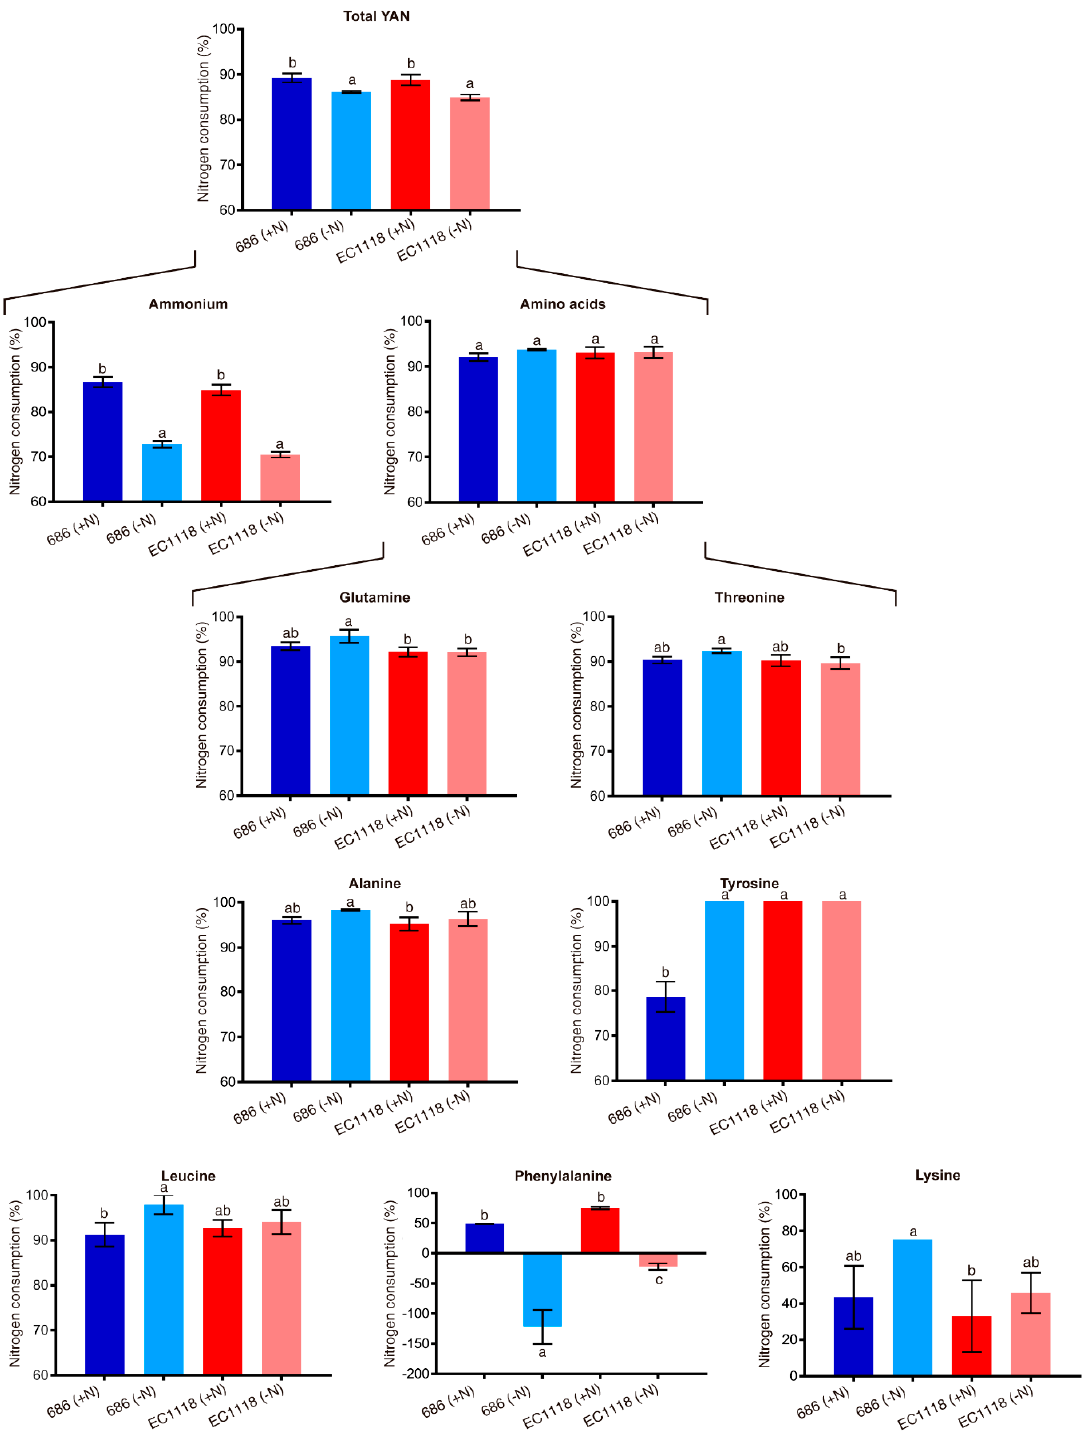
Figure 3. YAN consumption of improved strain “686” and commercial strain EC1118. Percentage of consumption of nitrogen sources are shown for fermentations in supplemented ( + N) and non-supplemented ( − N) musts. Statistical analysis for each nitrogen source consisted in independent ANOVA followed by Tukey’s tests, with values that have a statistically significant difference ( p -value < 0.05) having different superscript letters (a, b and c). Plotted values correspond to three biological replicates average, with error bars representing their standard error (mean ± SEM).